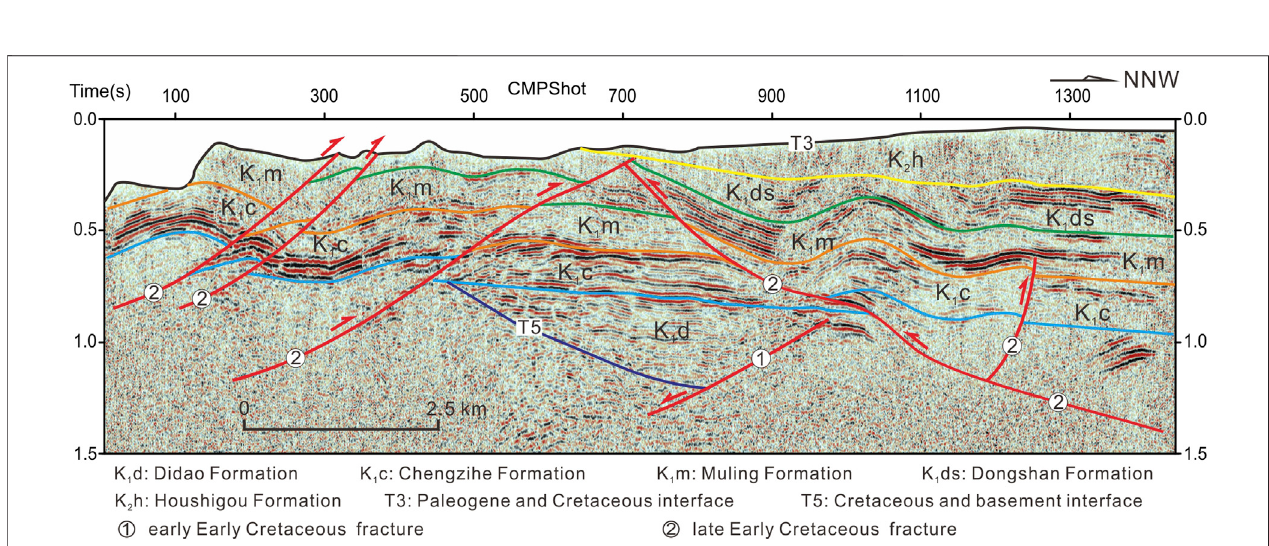
FIGURE 3 | Seismic re fl ection characteristics of compressional faults from late Early Cretaceous to early Late Cretaceous (Southern Jixi basin). Data from the project research team.